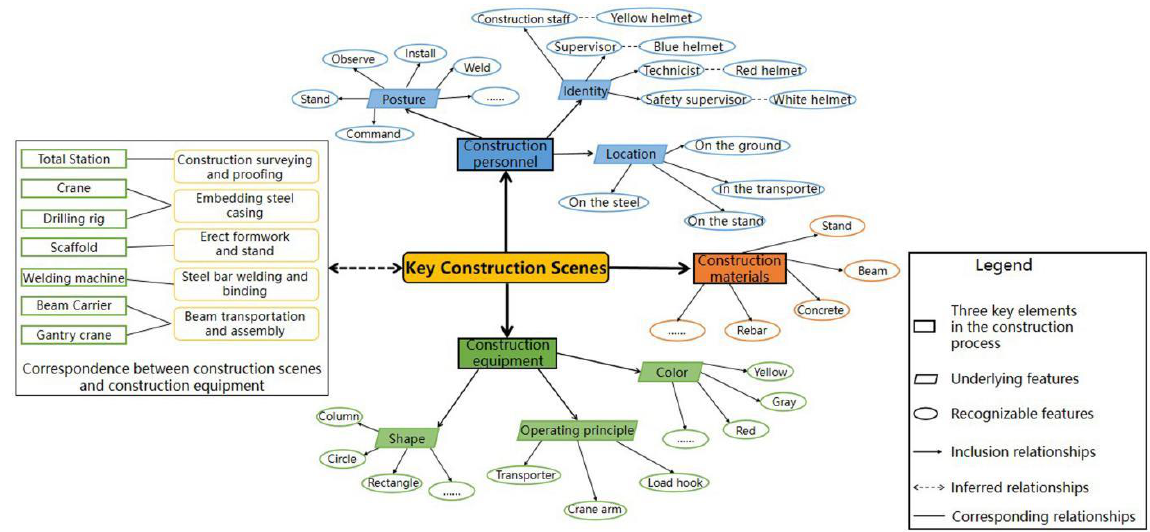
Figure 2. Identification rules tree diagram of bridge key construction scenes.